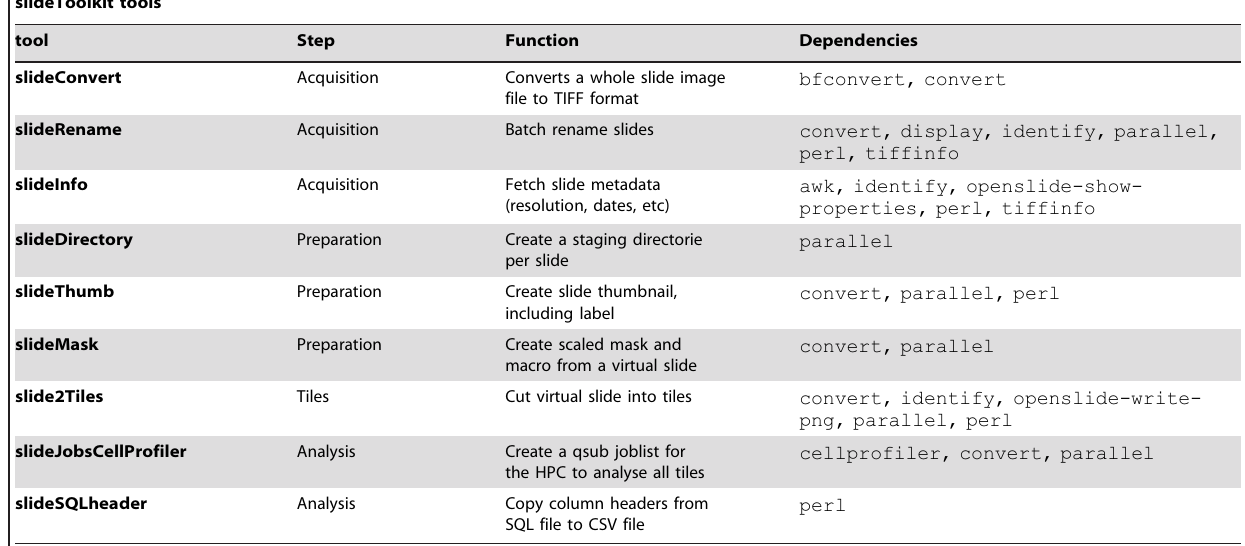
Table 1. Tools available in the slideToolkit.